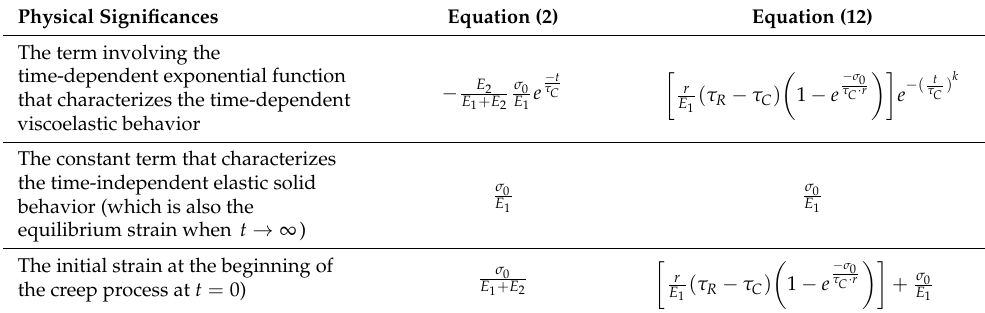
Table 3. Physical significances of our proposed constitutive equations derived with finite loading rate, i.e., Equation (12), and the traditional equations derived with infinite loading rate, i.e., Equation (2), for